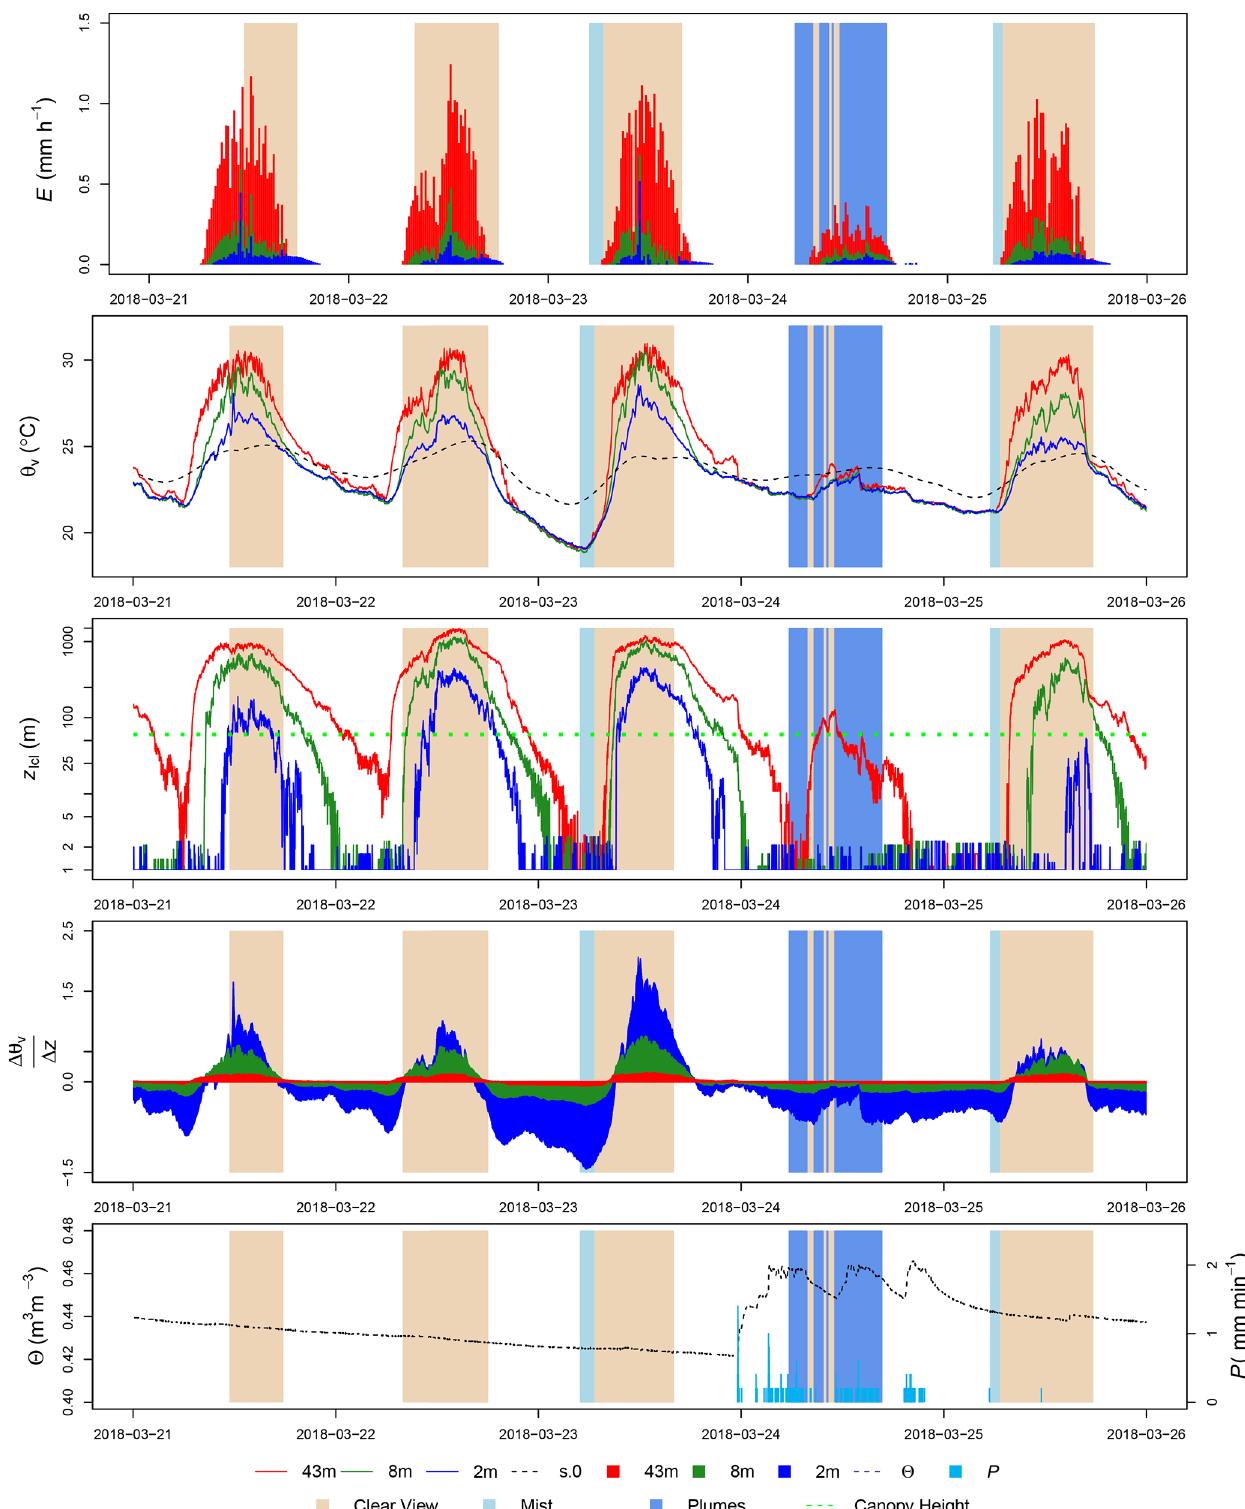
Figure 3. Virtual potential temperature ( θ v ), lifting condensation level ( z lcl ) in an untransformed semilogarithmic scale, and temperature gradient ( (cid:49)θ v ) at 43, 8 and 2m height. Additionally, precipitation ( P ) and soil moisture ( (cid:50) ) are shown during the visual monitoring between (cid:49)z 21 and 25 March 2018. Evaporation ( E ) measurements were retrieved from Jiménez-Rodríguez et al. (2020). Background-colored areas denote the three categories in which the photographs were classified: clear view, mist, and